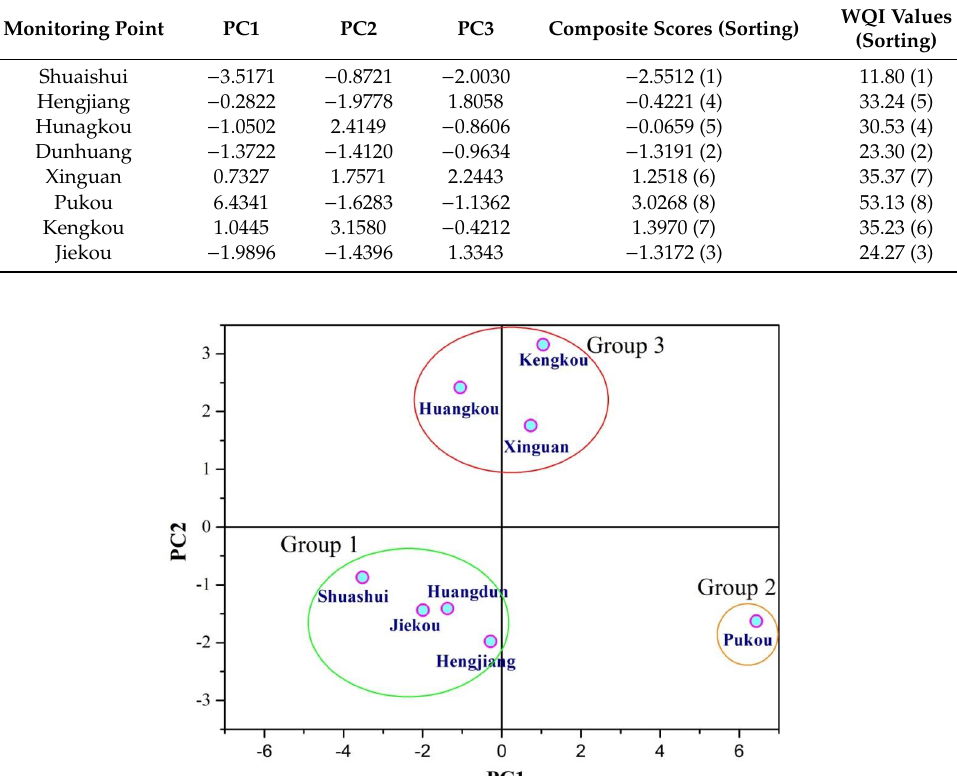
Table 3. Comprehensive evaluation value.